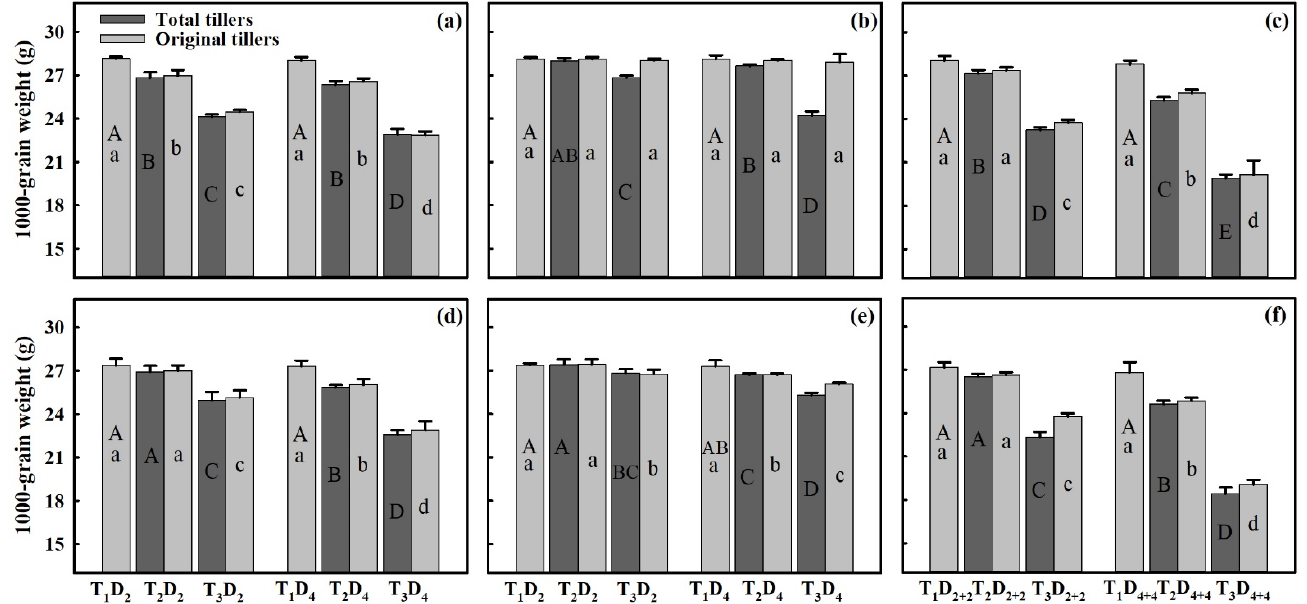
Figure 6. Effects of different high-temperature levels treatments on 1000-grain weight including total (original and regenerated tillers) and original tillers of Huaidao-5 and Wuyunjing-24 at booting (BT), flowering (FL), and combined (BT + FL) stages. ( a ) Huaidao-5 at BT treatment; ( b ) Huaidao-5 at FL treatment; ( c ) Huaidao-5 at BT + FL treatment; ( d ) Wuyunjing-24 at BT treatment; ( e ) Wuyunjing-24 at FL treatment; ( f ) Wuyunjing-24 at BT + FL treatment. Different uppercase and lowercase letters indicate significant differences at 0.05 level for total and original tillers, respectively. Vertical bars represent the standard deviation of the mean.